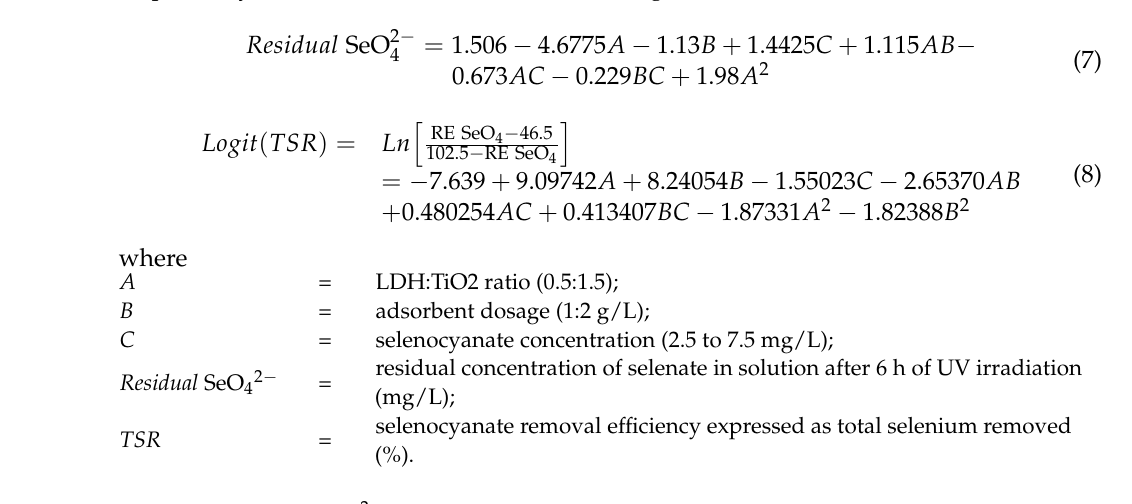
Table 5. Residual SeO 42 − (RS) and total selenium removal (TS) model fitting for selenocyanate